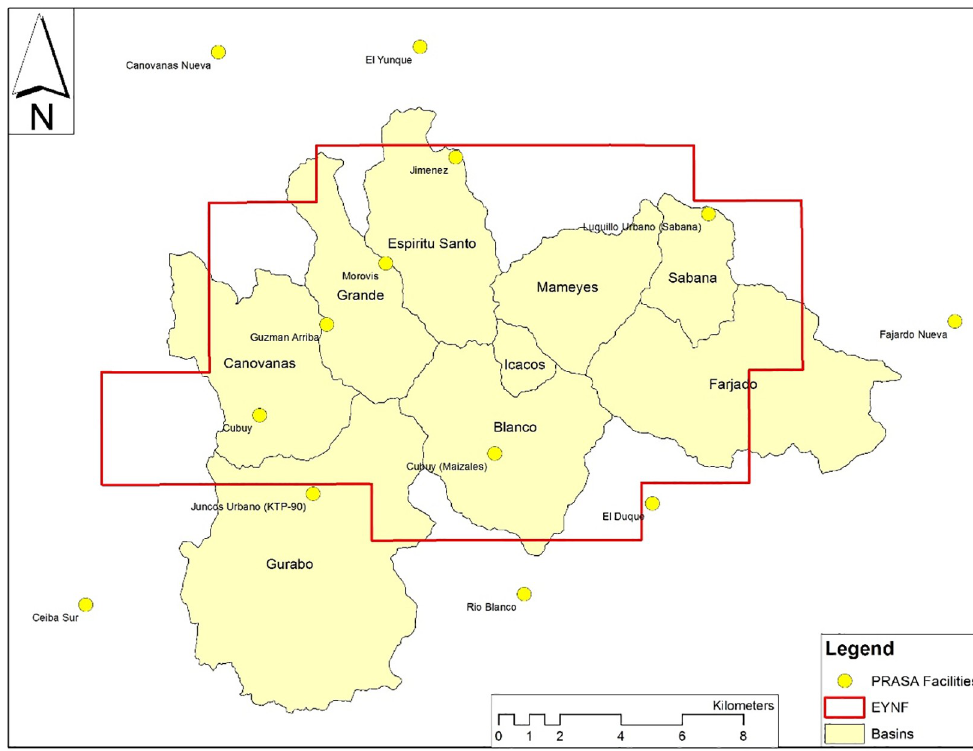
Fig 2. Puerto Rican Aqueduct and sewage authority intake locations within and adjacent to